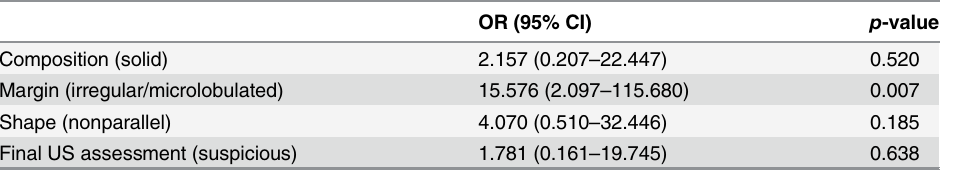
Table 4. Multivariate Analysis of Clinical and Ultrasonographic Characteristics for Predicting Malig- nancy of Repeat Bethesda Category III Nodules.